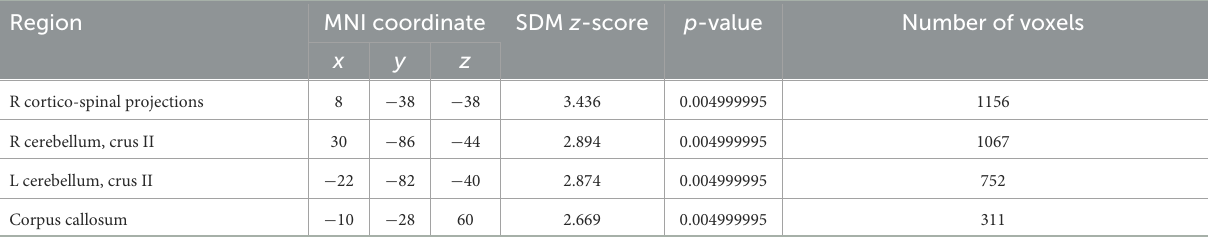
TABLE 6 Meta-regression analysis of mean age in treatment group. Region